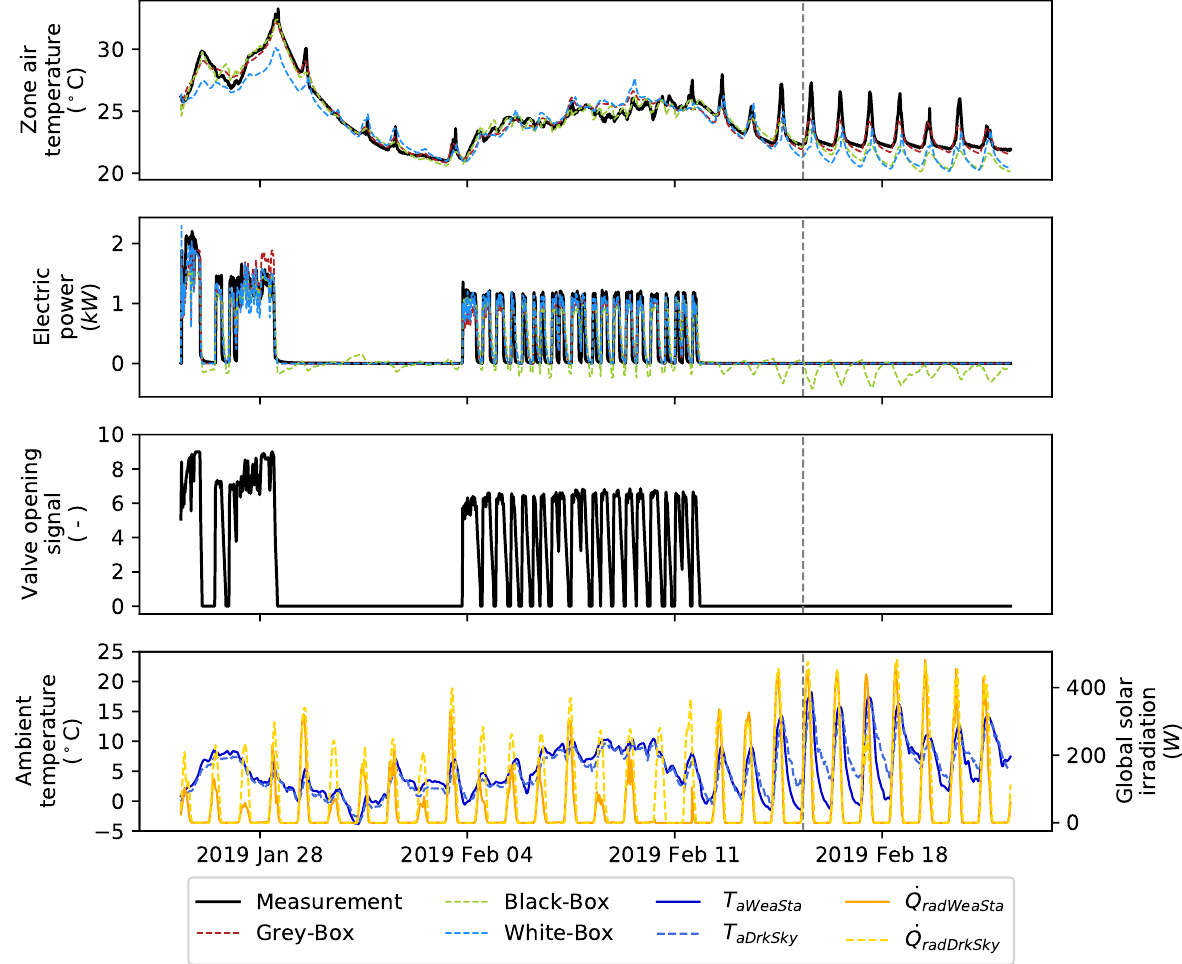
Figure 3. Comparison of the white-, grey-, and black-box models in prediction performance, together with the